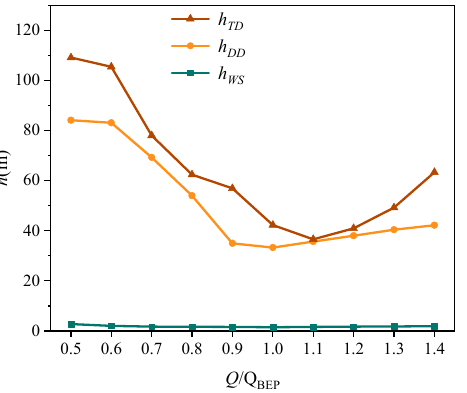
Figure 6. Evolution of each entropy production term under various operating points.